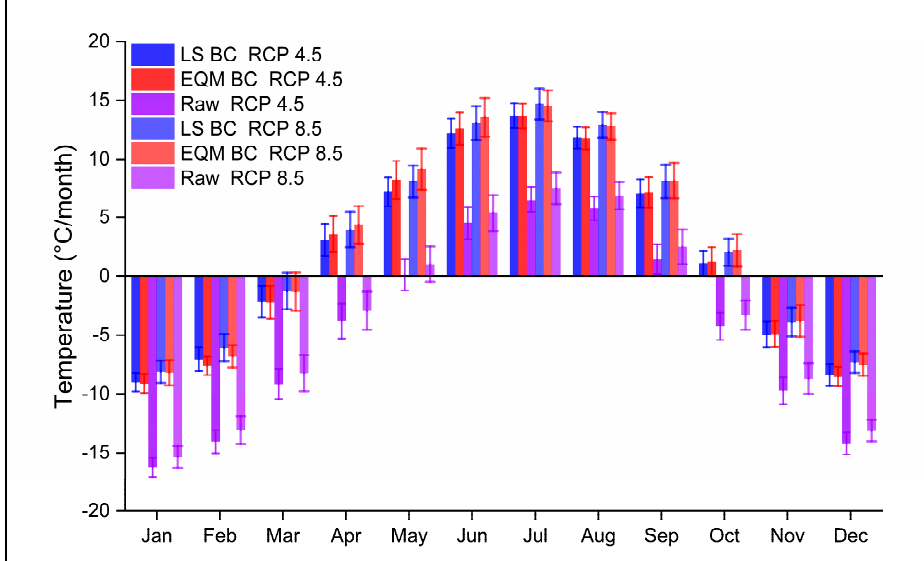
Figure 6. As Figure 5, but for mean monthly